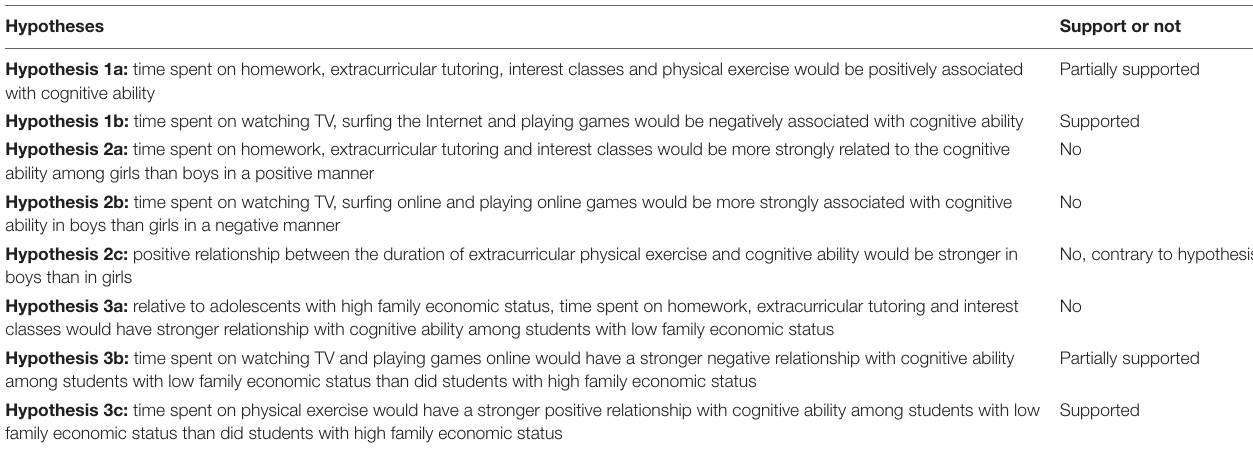
TABLE 7 | Summary of the support for the different hypotheses.